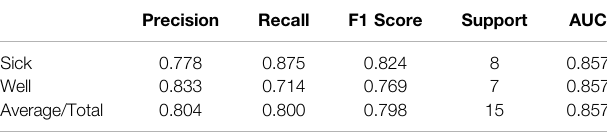
TABLE 1 | Evaluation metrics.